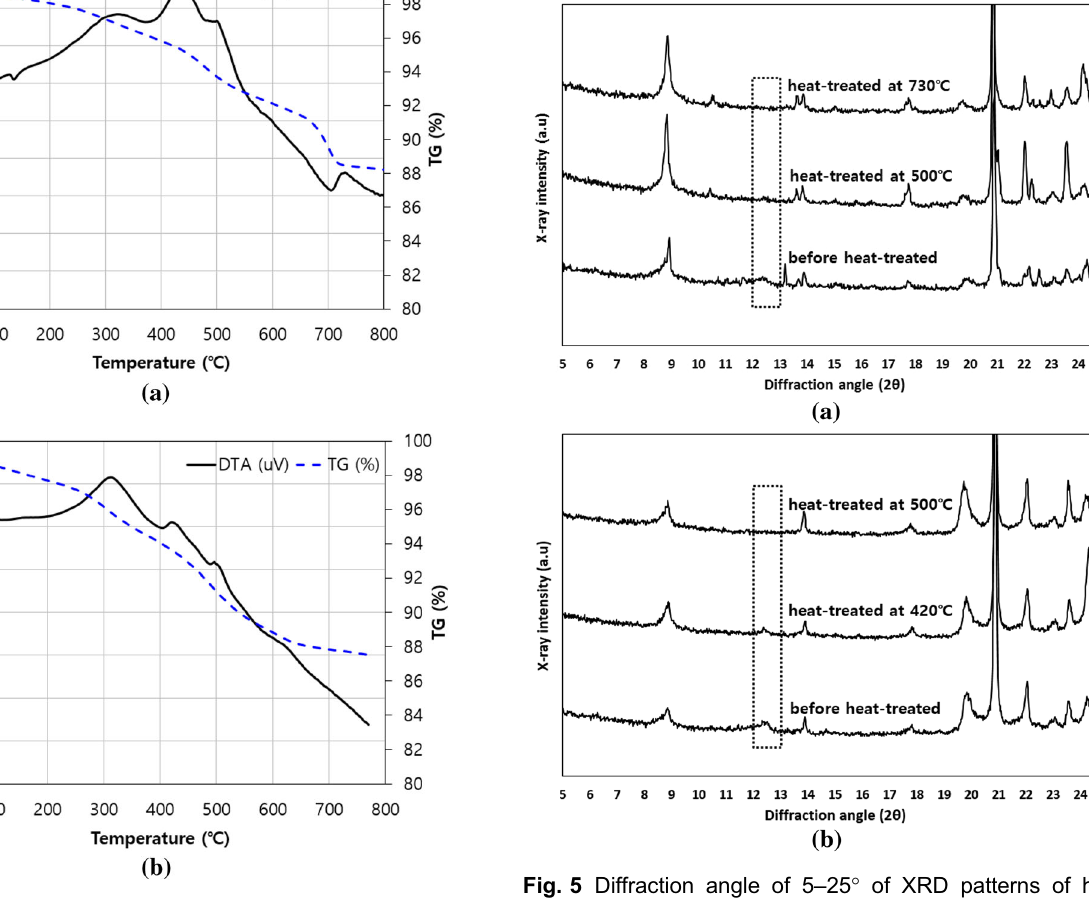
Fig. 4 TG/DTA of the dredged sea soil ( a SH, b JH)